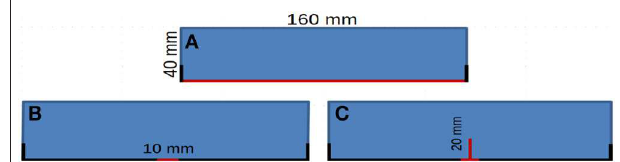
FIGURE 2 | Simulated situations where the red boundaries indicate the borders in contact with free water and the thick bold lines represent insulated borders. On the leftover boundaries, an evaporation process takes place. (A) The complete bottom boundary exposed to free water. (B) Just a tiny section of the bottom boundary exposed to free water. (C) Sample with a crack exposed to